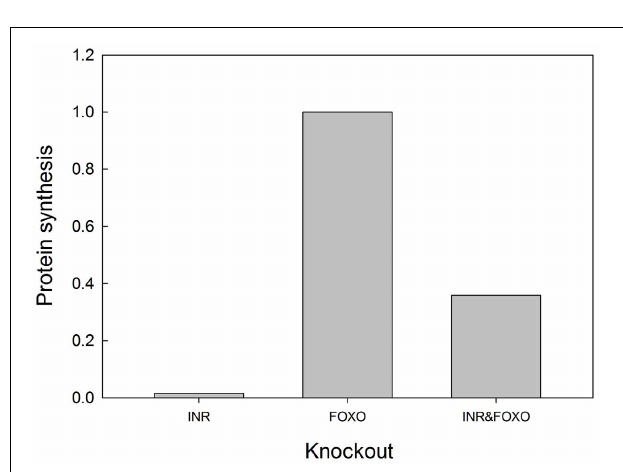
FIGURE 10 | FOXO knockout rescues the growth defects of INR mutants. In an INR deficient mutant, protein synthesis is severely depressed and regulated primarily by MAPK (activation of MAPK is set at 0.1 in this experiment). FOXO knockout alone has no effect on protein synthesis, but can partially rescue protein synthesis in an INR knockout. Protein synthesis values are scaled to those of a “wild type.” Input into the MAPK pathway is 0.1.